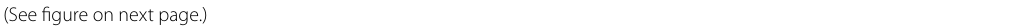
figure on next Fig. 9 a 3D volume rendering image showing tight focal aortic coarctation. b multiplanar sagittal image showing tight focal coarctation immediately distal to the left subclavian artery. c 3D volume rendering image showing double aortic arches (complete vascular ring). d 3D volume rendering image showing well deployed expanded stent with starting aneurysm within its mid segment. e 3D volume rendering image showing truncus arteriosus type